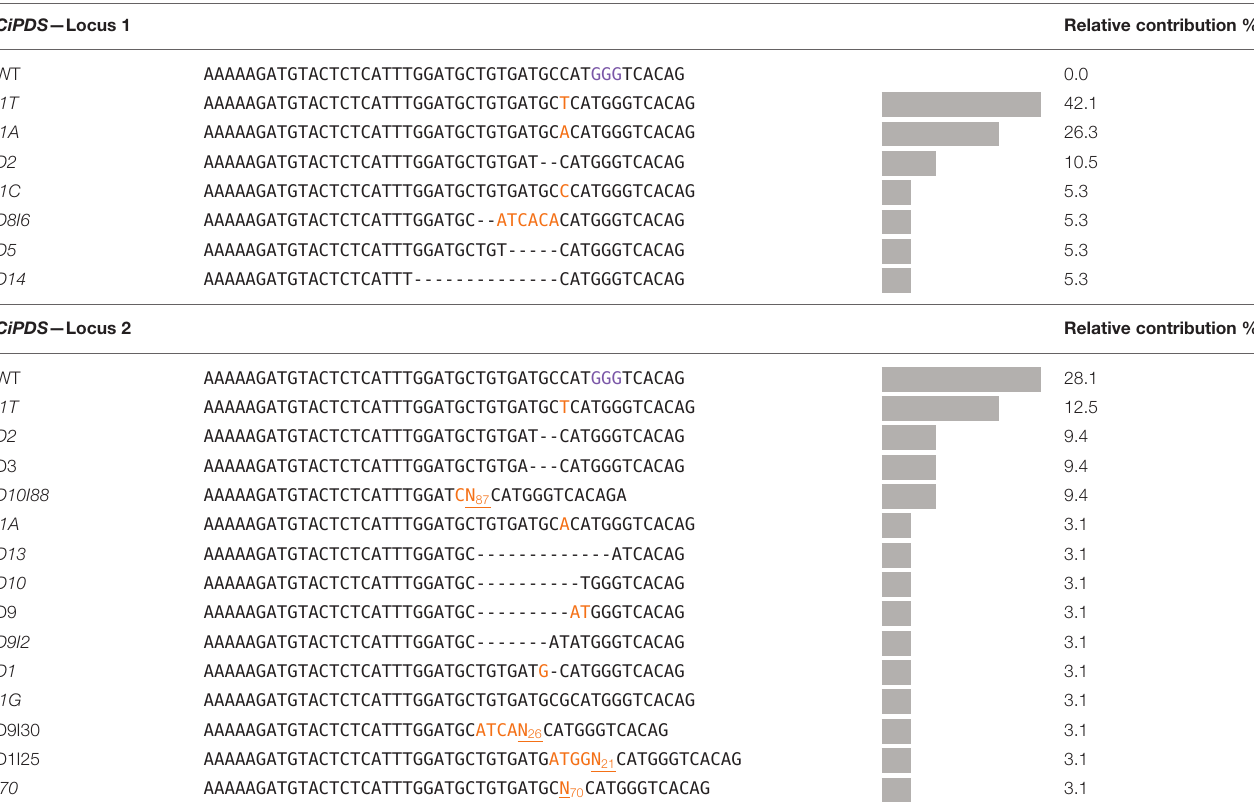
TABLE 4 | Overview of the mutation types and relative contribution of each mutation type in the ten mutated albino